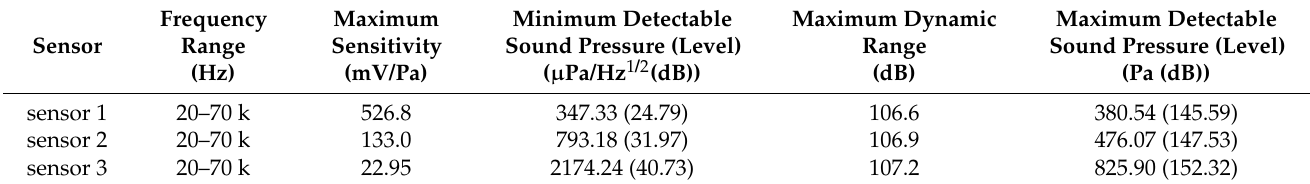
Figure 15. The maximum and minimum detectable sound pressures of the three FOASs at different modulation frequencies. Table 2. Optimal performance comparison of the three